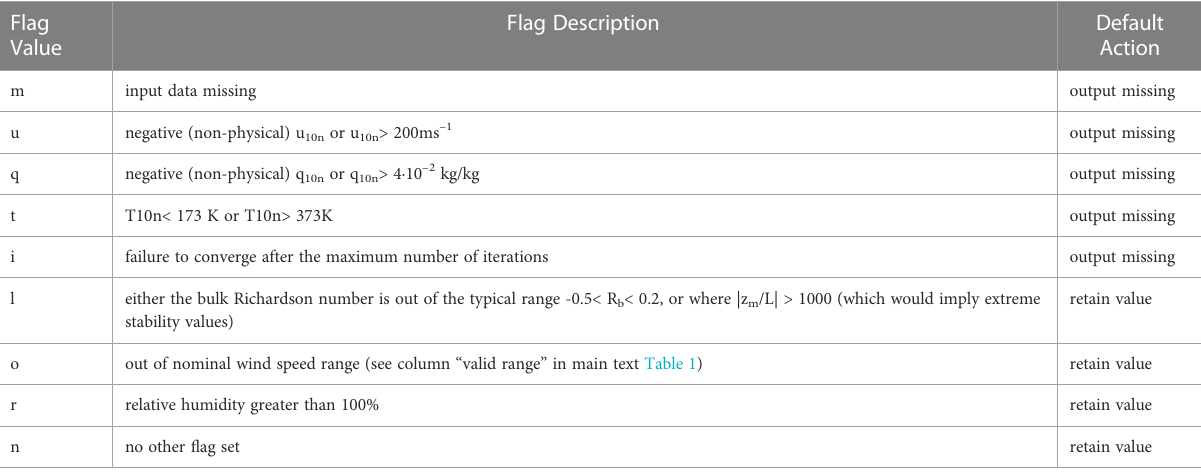
TABLE 7 Summary of quality control fl ags provided as output in